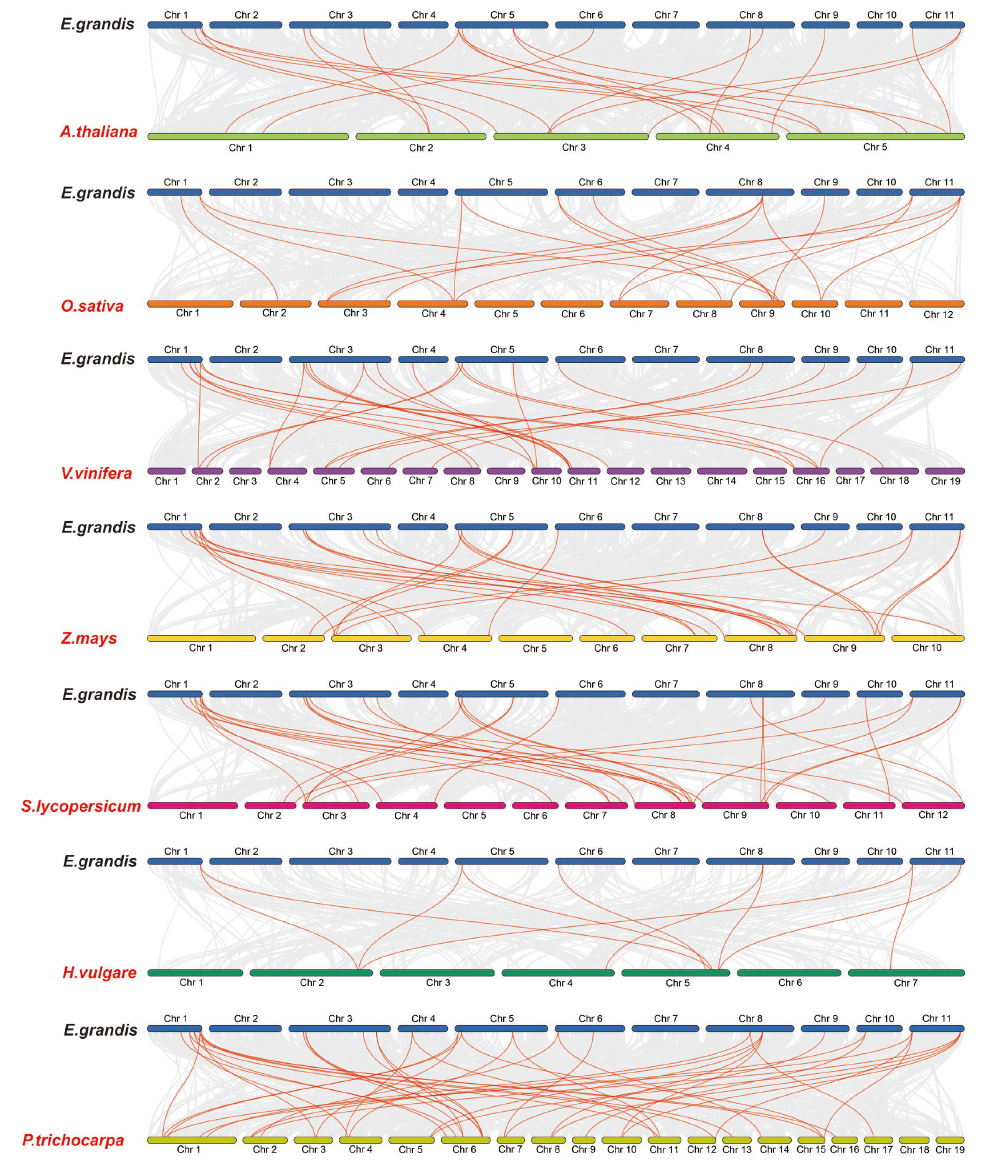
Figure 3. Homology analysis between eucalyptus genome and seven plant genomes ( Arabidopsis thaliana , Zea mays , Oryza sativa , Vitis vinifera , Populus Tomentosa , Hordeum vulgare and Solanum lycoper- sicum ). The grey lines symbolize the aligned blocks between paired genomes, and the red lines stand for collinear EgHsf gene